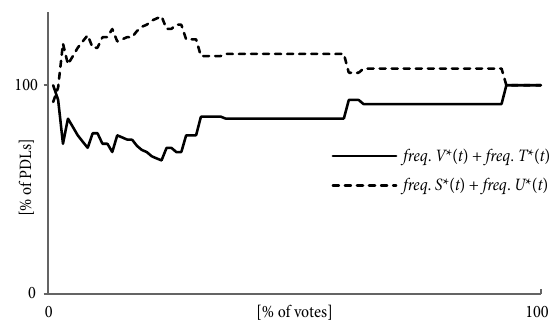
Fig. 7. The sum of frequencies of mishits and the sum of frequencies of hits